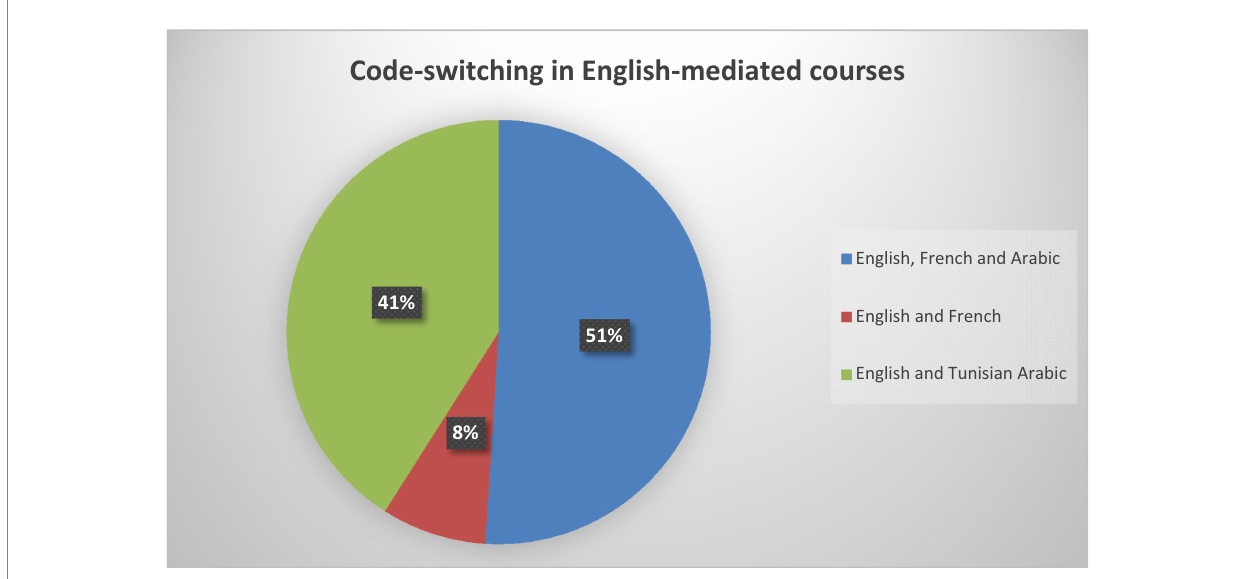
FIGURE 1 What languages do teachers mix? (Item 35, Number of respondents,